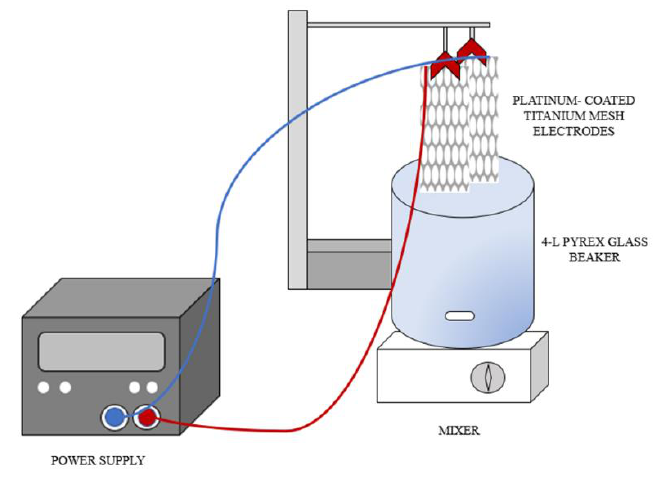
Figure 1. Electrolysis Setup